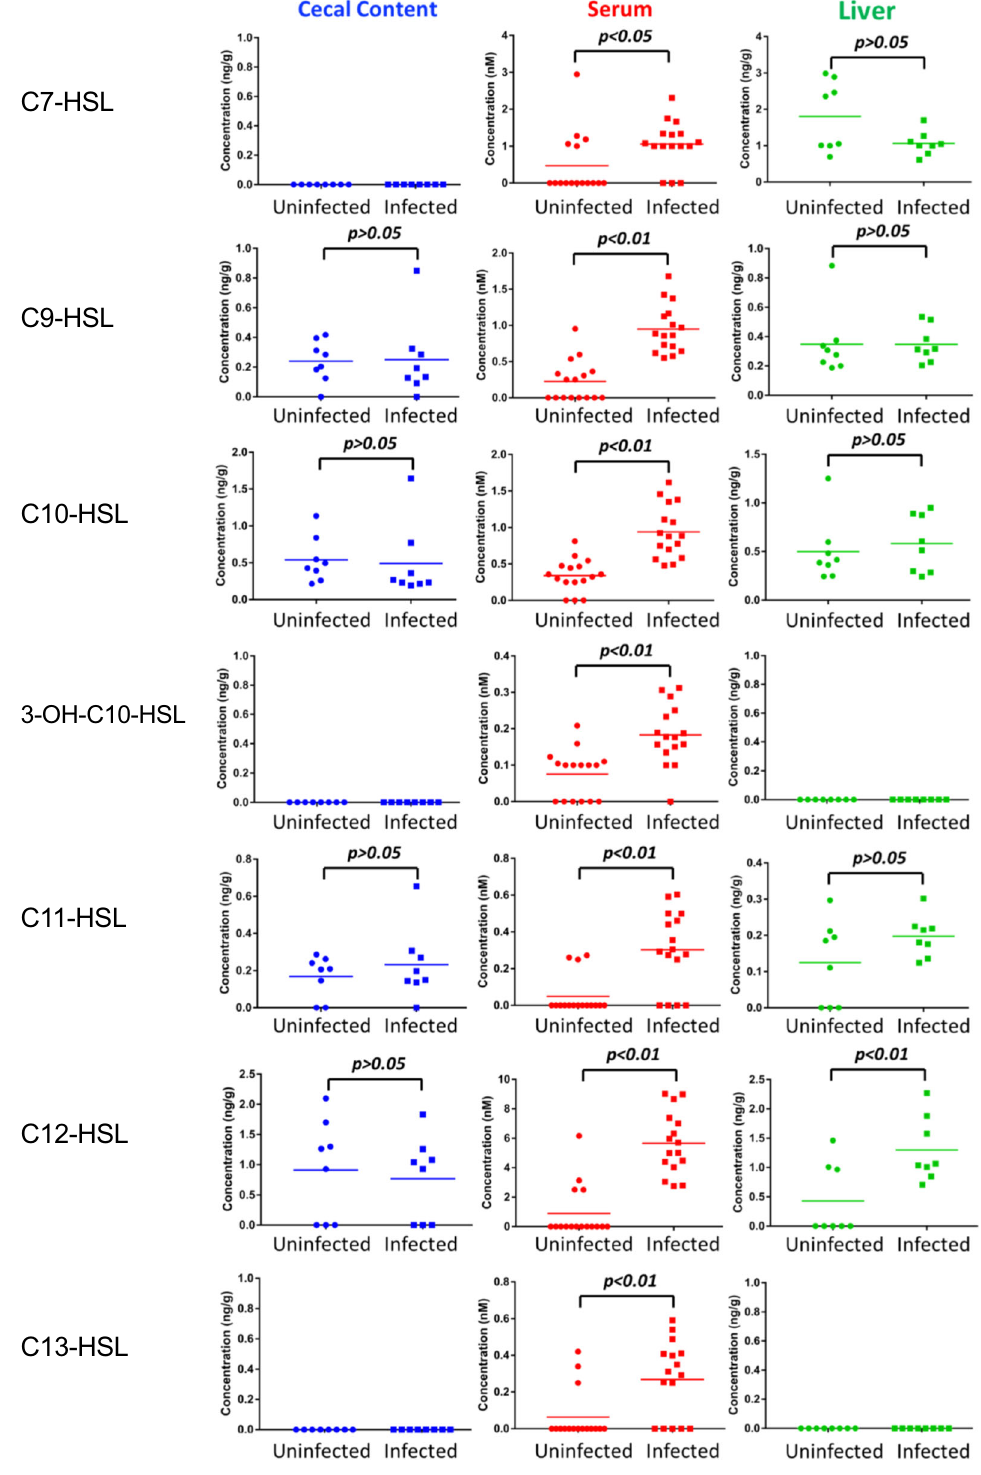
Fig. 5 Differences of non- C. rodentium produced AHLs level in the biological samples (cecal contents, sera, and livers) between uninfected and infected mice. AHLs in the serum of infected mice were signi fi cantly increased compared to non-infected